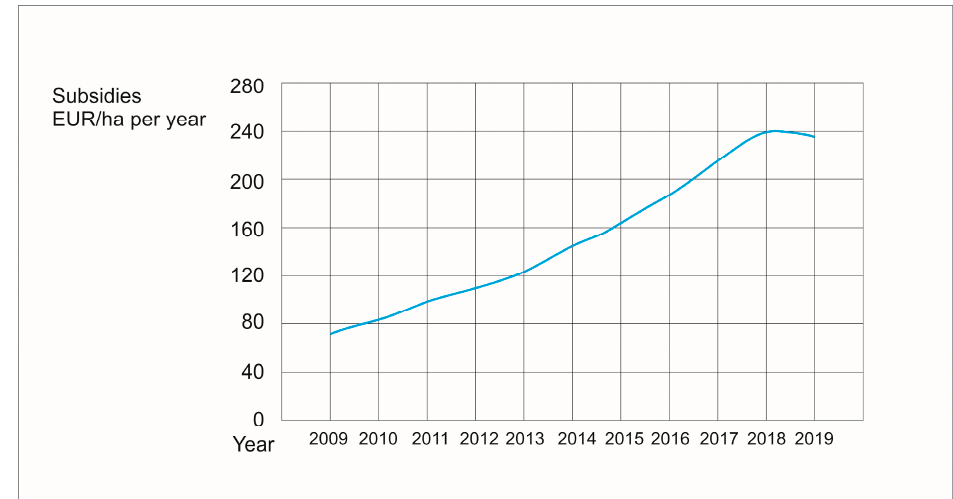
Figure 4. Subsidies in the Czech Republic (2009–2019).